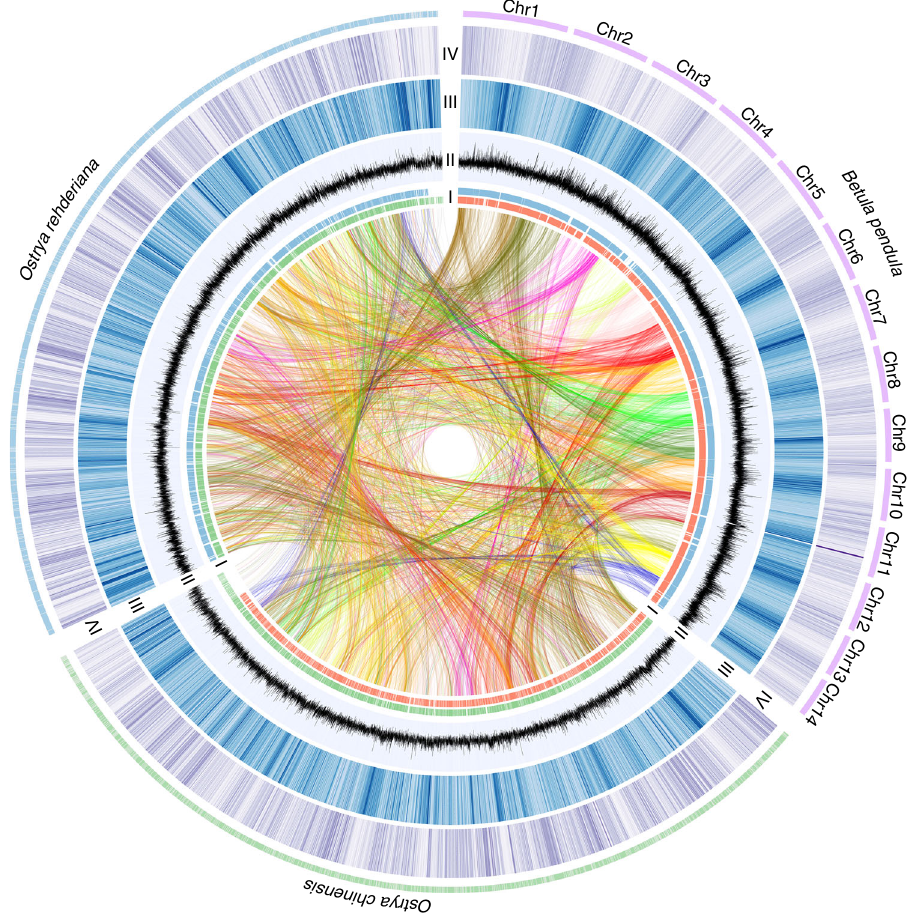
Fig. 1 An overview of O. rehderiana (blue), O. chinensis (green), and B. pendula (purple) genomes. Different tracks denote (moving outwards): (I) synteny blocks between O. rehderiana and O. chinensis (green), O. rehderiana and B. pendula (blue), and O. chinensis and B. pendula (green); (II) GC content (0.2 – 0.8); (III) repeat density at 10 kb (0 – 1, from white to dark blue); and (IV) gene density in 10 kb (0 – 30, from white to purple). Links in the core connect syntenous genes (MCscanX